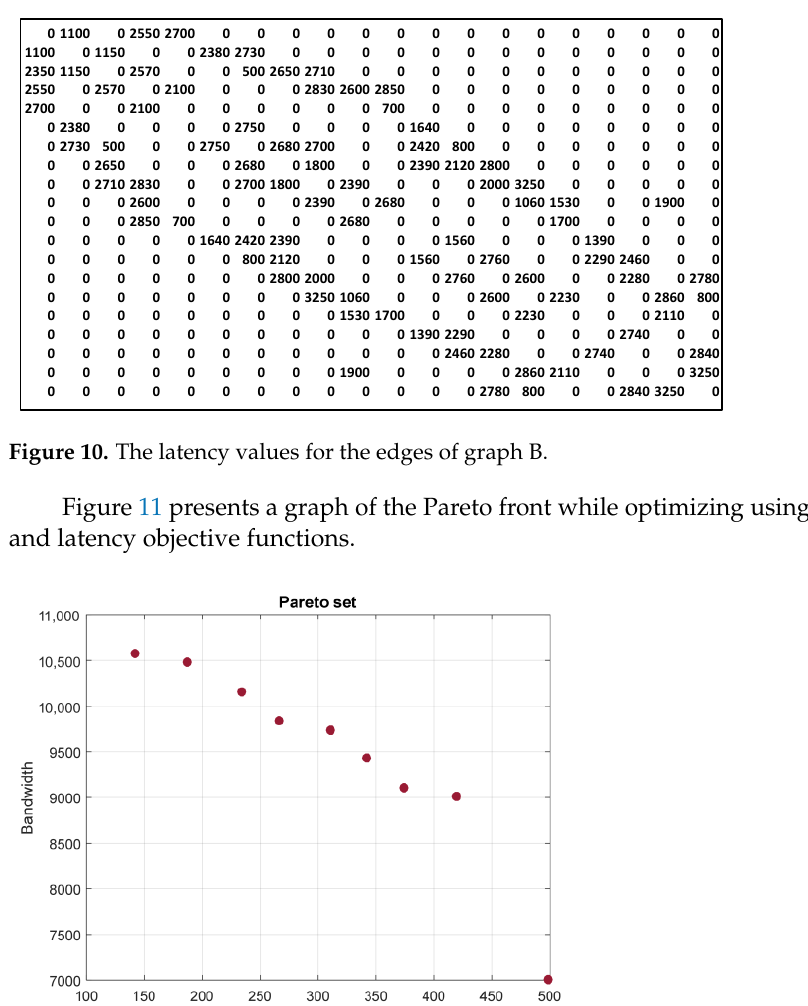
Figure 11. The Pareto front of the two-dimensional optimization of graph B. The complete results are summarized in Table 4, with the AHP evaluation scores added as the fifth column. We used a swarm of 40 particles and 50 iterations for the PSO part of the optimization. Table 4. The Pareto set of the alternative paths for graph A.